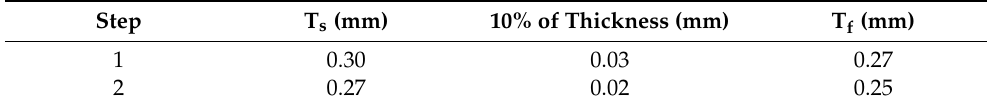
Table 1. Steps of the rolling process.